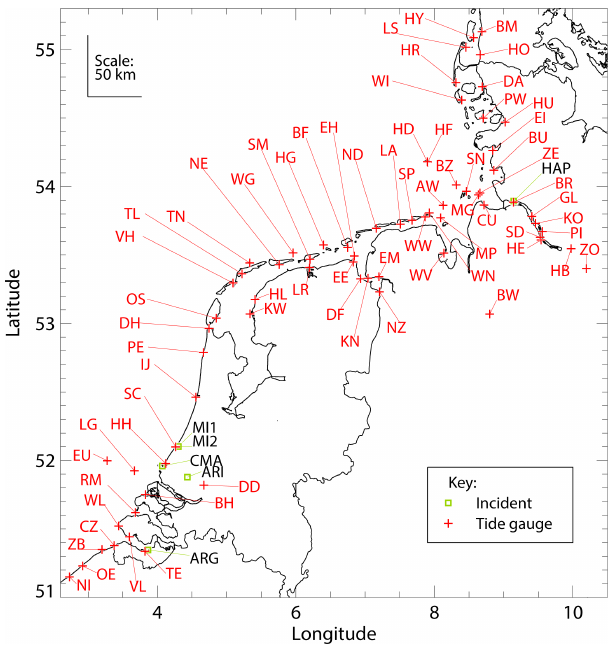
Figure 4. Location of tide gauges and maritime incidents along the North Sea coasts of the Netherlands, Germany, and southern Den- mark. The abbreviation codes for the tide gauges and maritime in- cidents are explained in Tables S9.1 and